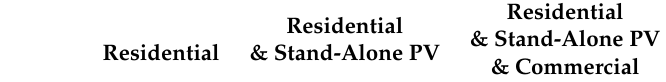
Table 12. Shares of load coverage by different levels of the REC. Shares are given for residential customers only (for the use case residential + stand-alone PV + commercial, the load coverage of the commercial business is not considered) to ensure comparability of